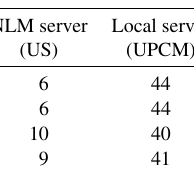
Medical students’ preferences comparing NLM (US) and UPCM (local)